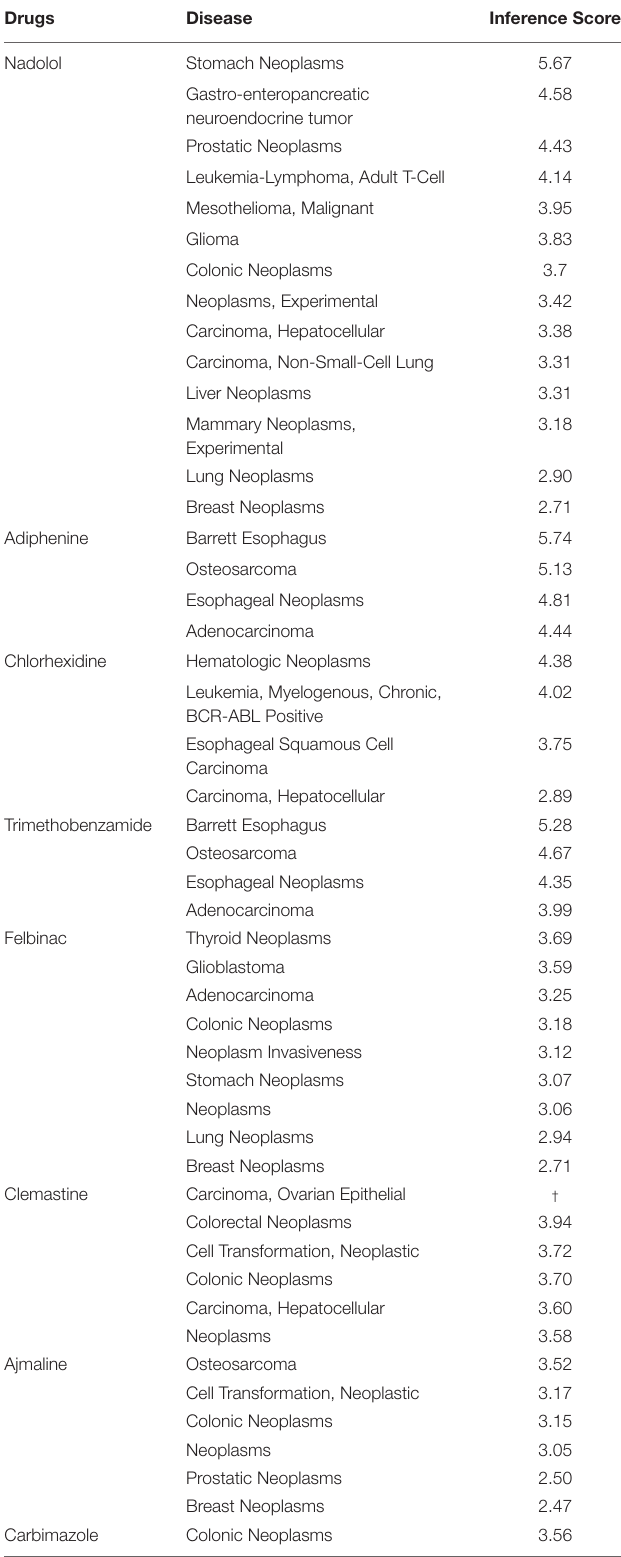
TABLE 3 | Relationship between cancers and eight potential drugs based on CTD. Drugs